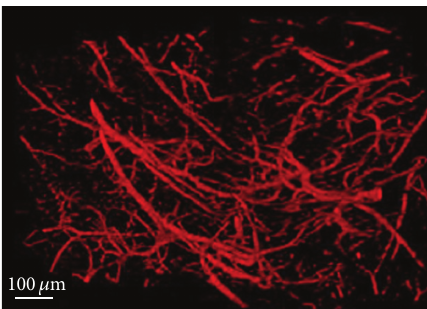
Figure 5: Enlarged 3D view of microvasculature in the brain region of interest (black box area in Figure 4(a); also see the supplementary video, in Supplementary Material available online at http://dx.doi.org/10.1155/2016/3258494). The scale bar is 100 𝜇